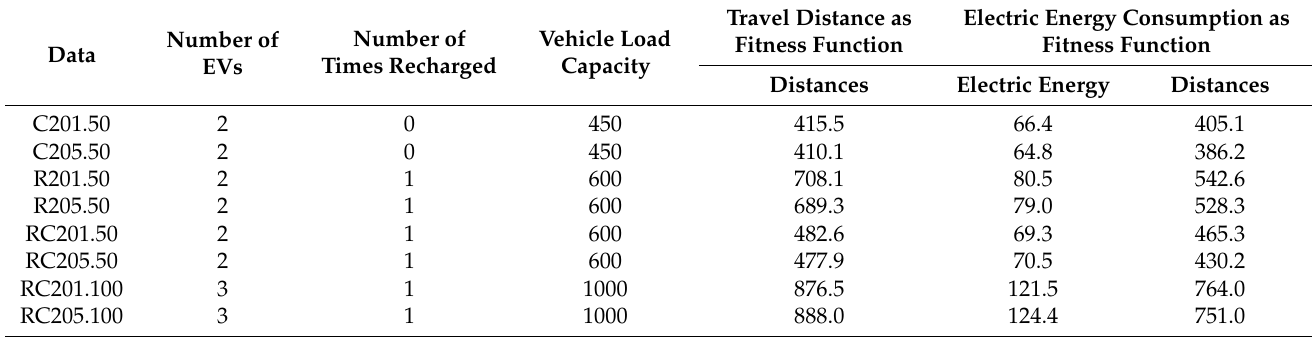
Table 5. Performance comparison of NR-EGA with different fitness